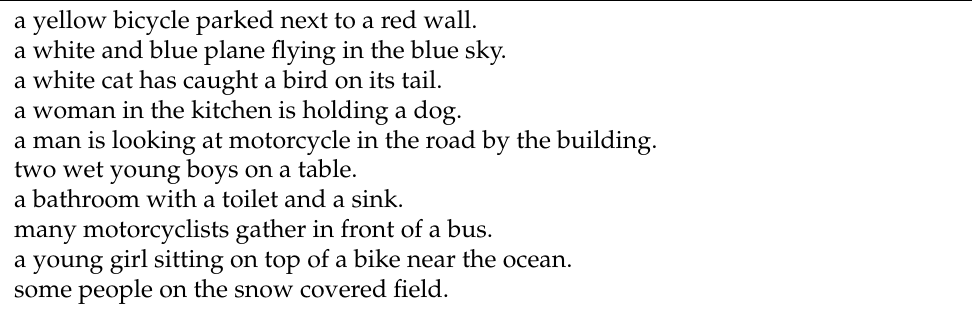
Table A1. The data samples generated from the COCO image caption dataset.